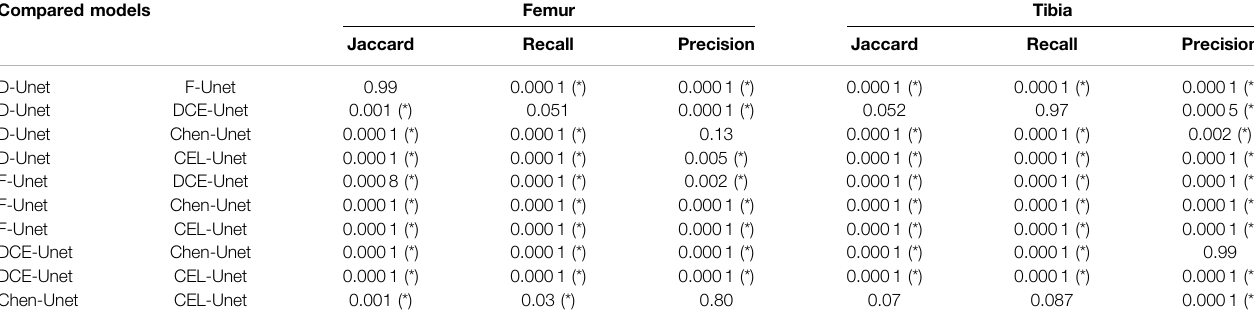
TABLE 6 | Statistical results ( p values) about comparison of the fi ve segmentation networks. Asterisk means statistical difference at 5%. Compared models Femur Tibia Jaccard Recall Precision Jaccard Recall